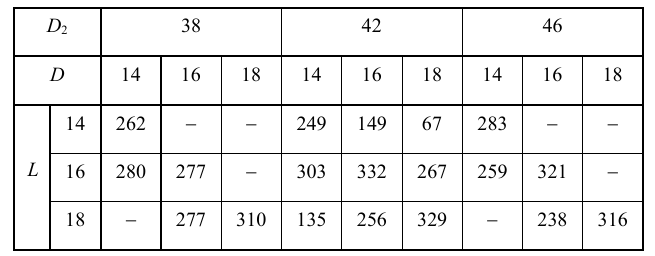
Variation of mass loss with nozzle